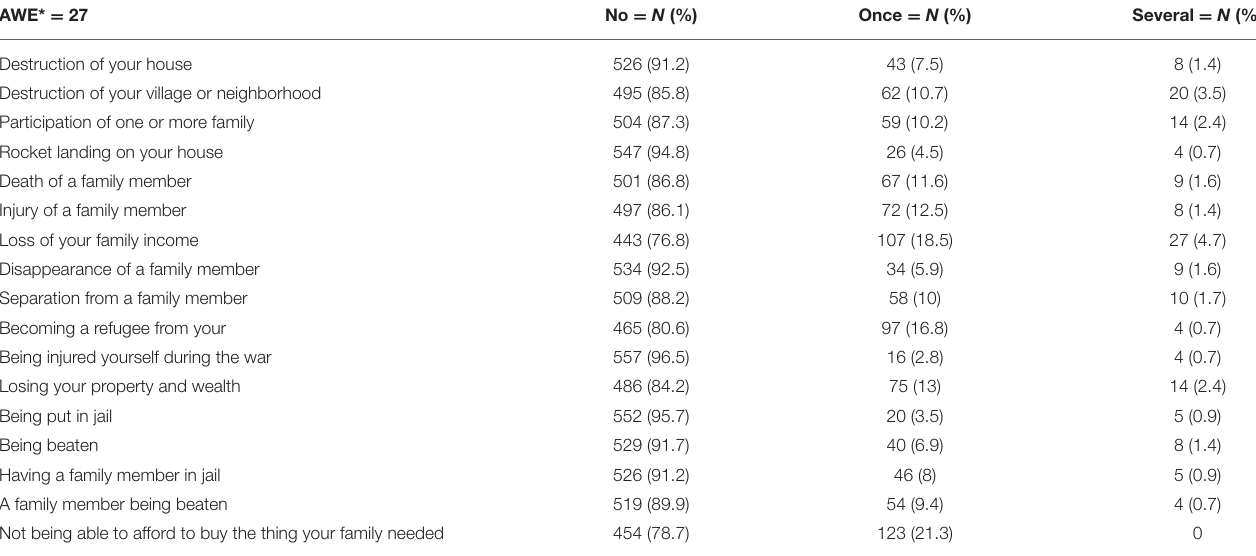
TABLE 4 | Descriptive statistics of Afghan War experiences